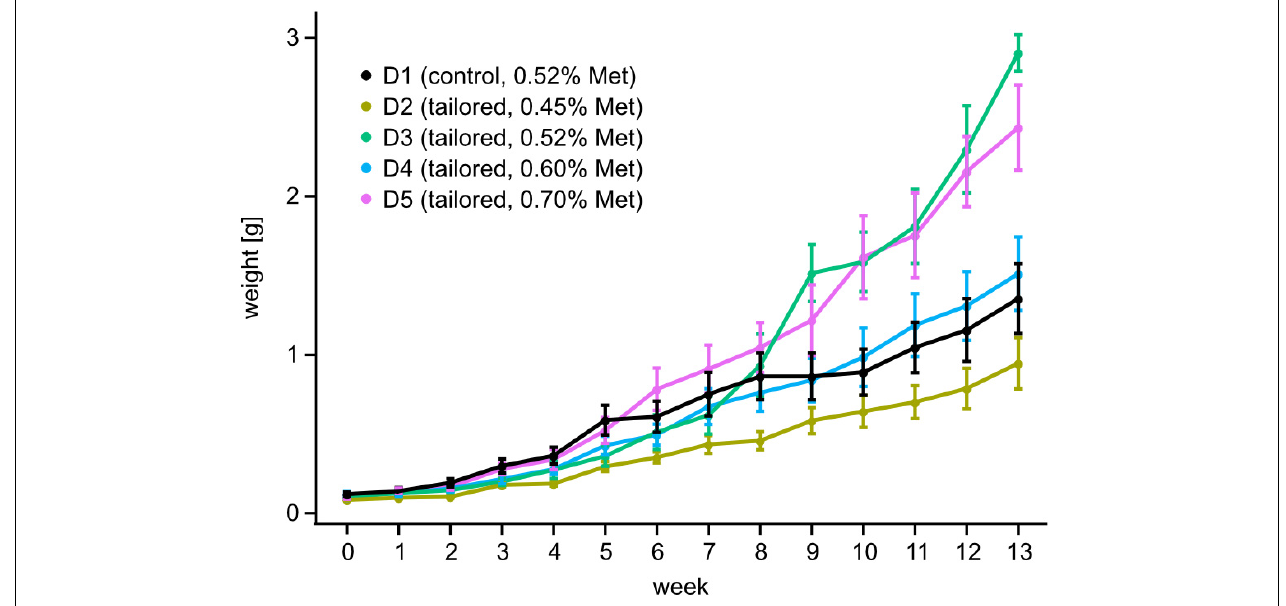
FIGURE 3 | Growth of laboratory-cultured, adolescent marbled crayfish fed with tailored feeds. Growth curves are shown for diets D1–D5, with different methionine concentrations, as indicated. A generalized estimating equations model revealed a statistically significant weight gain for diet D3 ( p = 0.02) and D5 (0.03) when compared to diet D1. Error bars indicate the standard error.